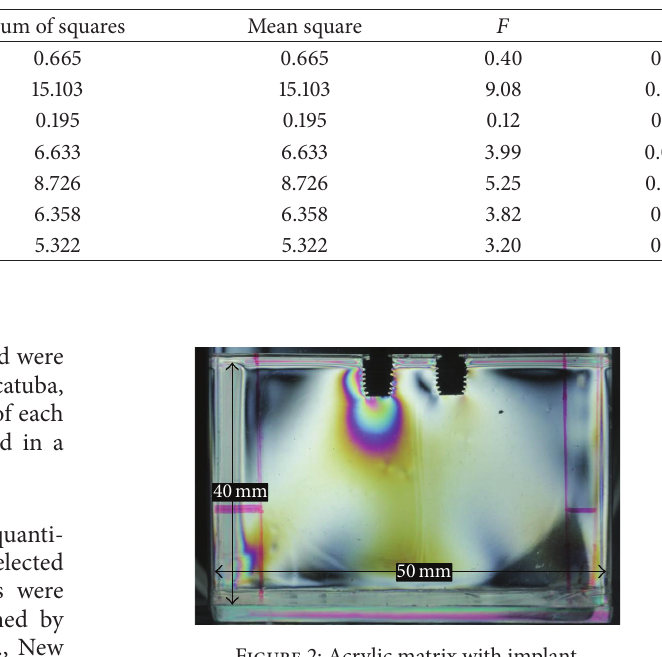
Figure 2: Acrylic matrix with implant.